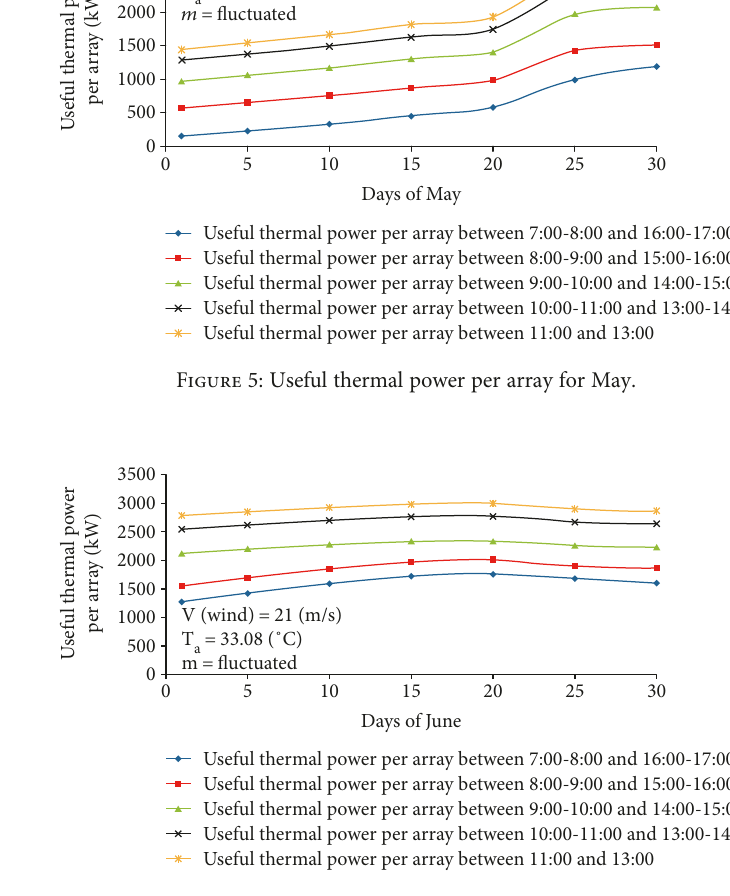
Figure 6: Useful thermal power per array for June.